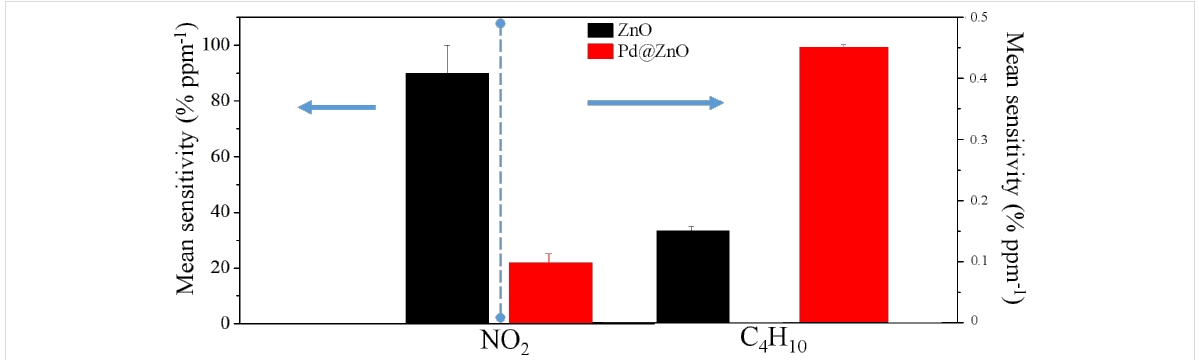
Figure 7: Mean sensitivity of pristine and Pd@ZnO NRs towards NO 2 and C 4 H 10 at an operating temperature of 300